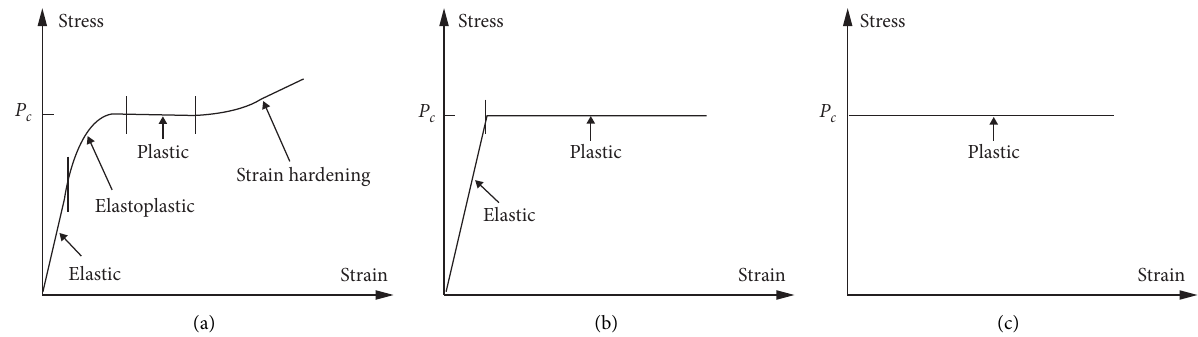
Figure 1: Deformation curves: (a) common material; (b) ideal elastoplasticity; (c) rigid